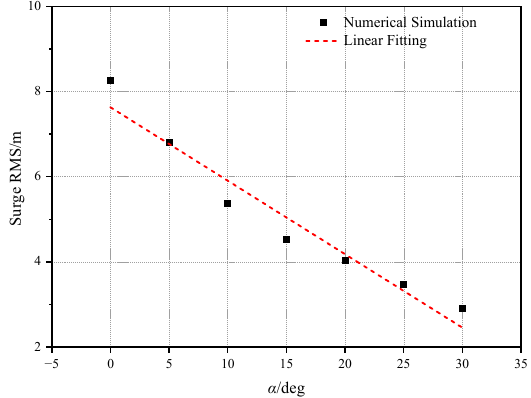
Figure 12. Surge responses with different inclined angles.